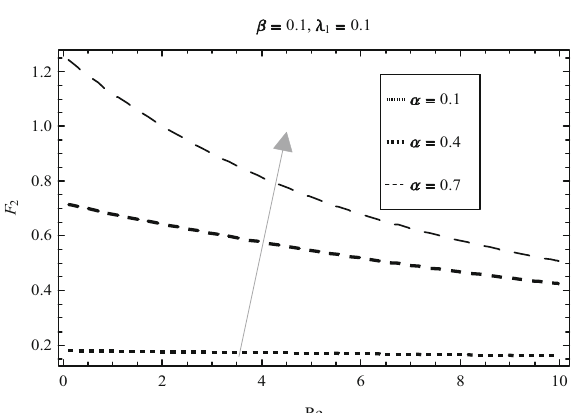
Fig. 21 Variation of F 2 along Re for different values of α